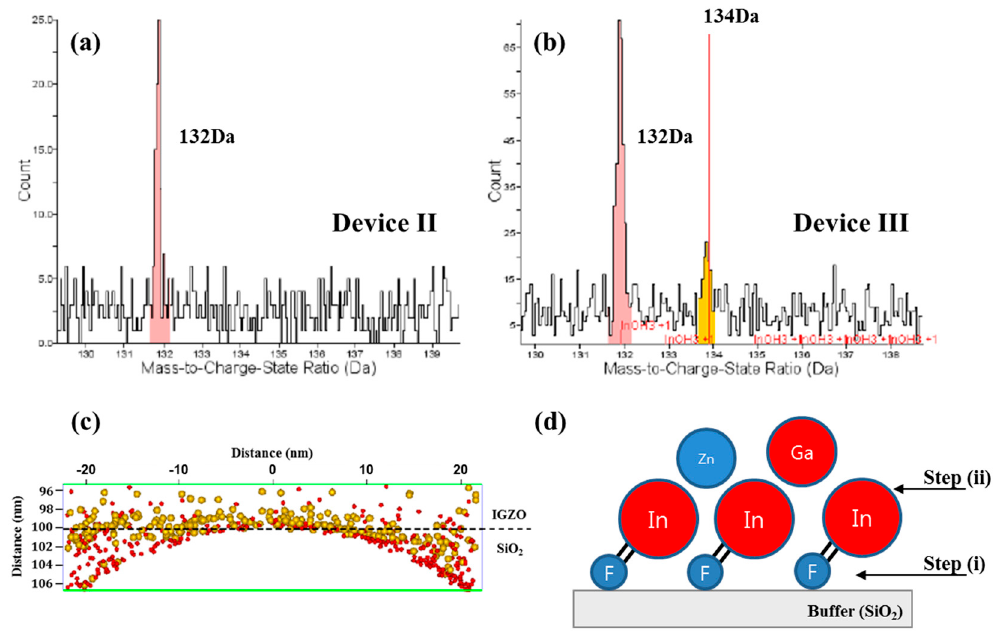
Figure 4. High-resolution TEM (HR-TEM) images of the gate insulator (GI) (SiO 2 ) / active (IGZO) / bu ff er (SiO 2 ) interfaces for devices ( a ) I, ( c ) II and ( f ) III, respectively. Annular dark-field (ADF) images in a scanning TEM (STEM) for devices ( b ) I, ( d ) II and ( e ) III, respectively. ( g ) Enlarged interface of device III.